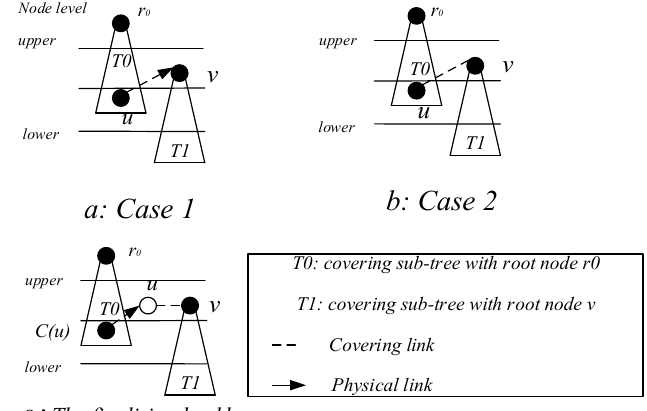
Figure 17. Case 1 and case 2 in finalizing backbone.